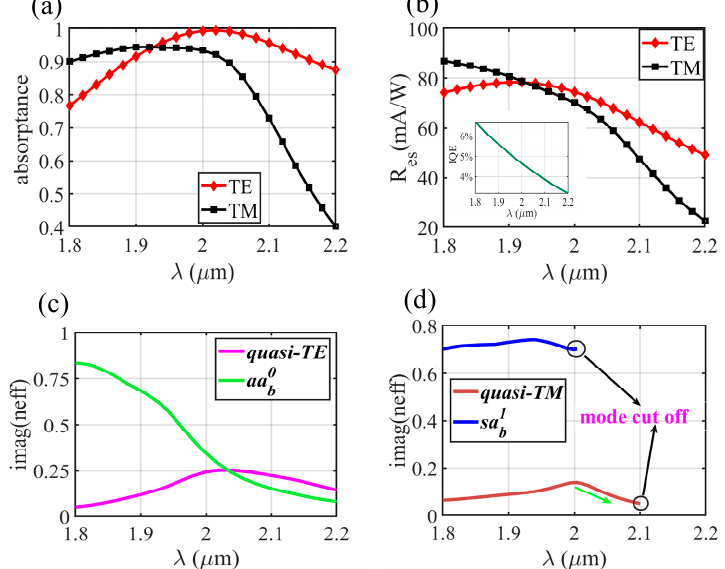
Figure 11. ( a ) Absorption rate and ( b ) responsivity of the single-layer Schottky PD under TE and TM incidence versus wavelength. Structure parameters: Au, h m = 7 nm, wt 1 = 0.1 µm, wt 2 = 0.14 µm, wt 3 = 0.31 µm, wt 4 = 0.338 µm, lt 1 = 0.2 µm, lt 2 = 0.5 µm, lt 3 = 1 µm, lt 4 = 0.5 µm, ls 1 = 2 µm, ls 2 = 4 µm. Imaginary